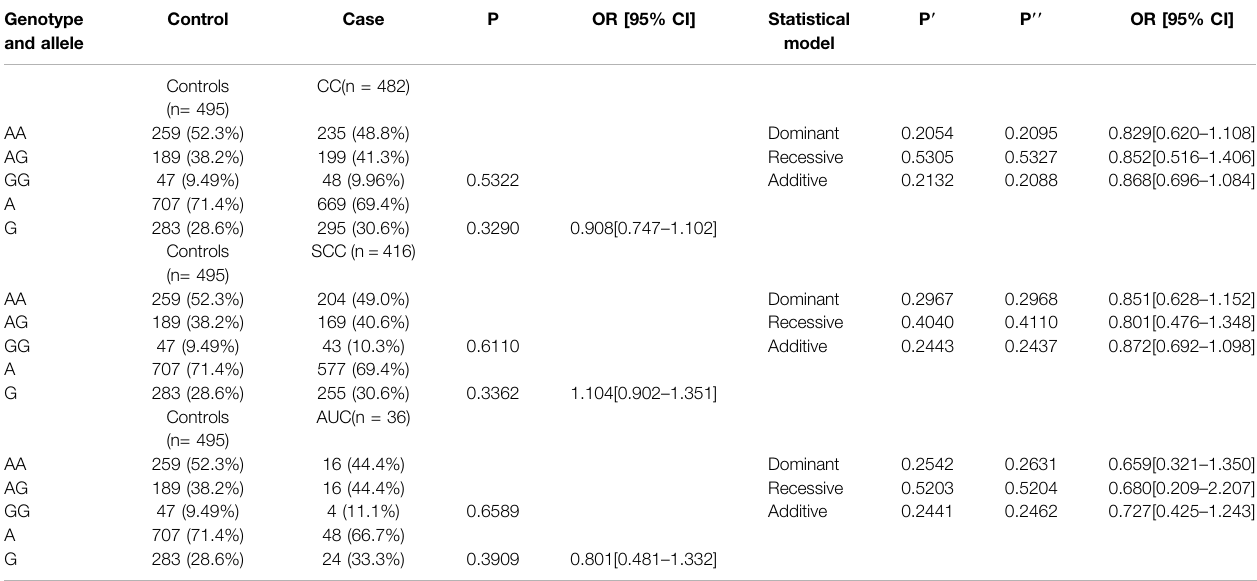
TABLE 2 | Comparison of genotypes and allele distribution frequencies between the CC group and its subgroups with the healthy control group. Genotype and